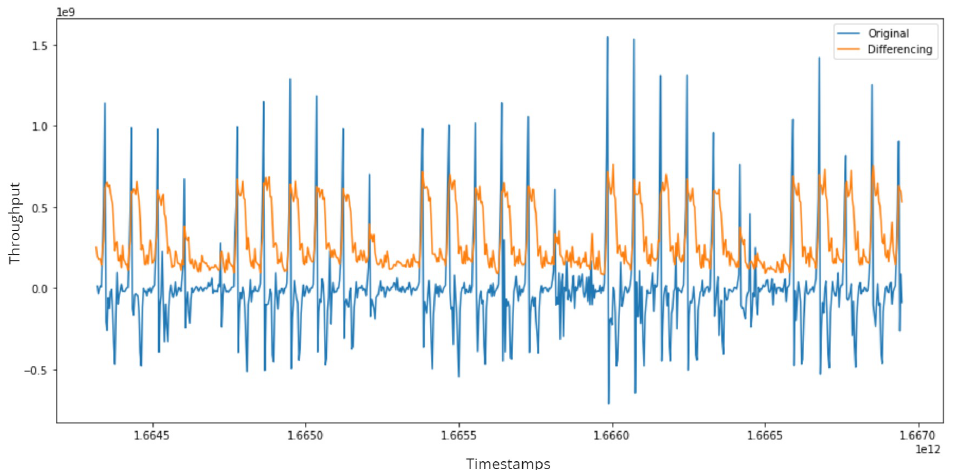
Figure 6. The original and differencing of subscriber data.